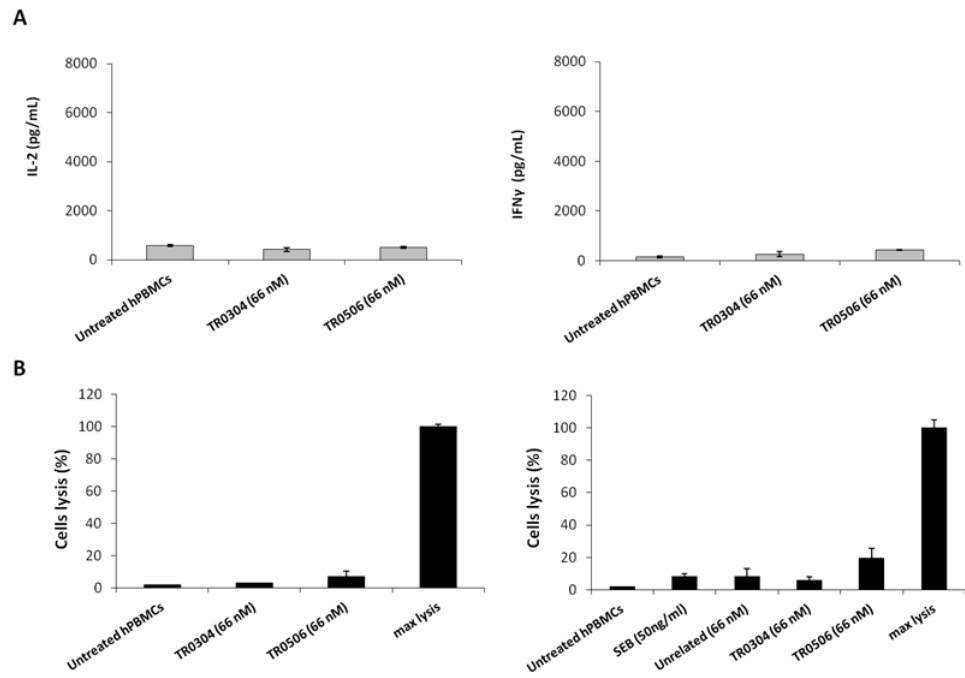
Figure 9. Effects of tribodies on naive lymphocytes. ( A ) Cytokines assays were performed on lymphocytes by treating them with the tribodies in the absence of stimuli. IL-2 and IFN γ released by lymphocytes were quantified and expressed as pg/mL. ( B ) To confirm the lack of toxicity of immunomodulatory tribodies on lymphocytes, T cell lysis was analyzed by measuring the increase of LDH in the supernatants of unstimulated hPBMCs treated with the tribodies, as indicated. Untreated hPBMCs were used as a negative control. Error bars depict means ± SD.